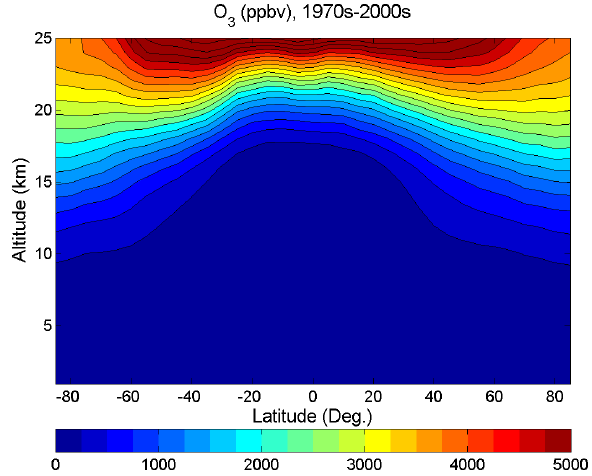
Fig. 10. Long-term latitude-altitude distribution of the ozone climatology (1970s-2000s).